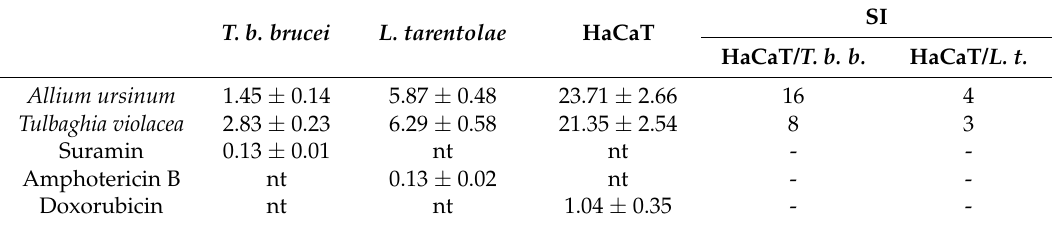
Table 4. Trypanocidal, leishmanicidal, and cytotoxic activity of Allium ursinum and Tulbaghia violacea extracts against Trypanosoma brucei brucei ( T. b. brucei ), Leishmania tarentolae ( L. tarentolae ), and HaCaT cells. The values are expressed as mean IC 50 ( µ g/mL) ± SD; nt: not tested; SI: selectivity